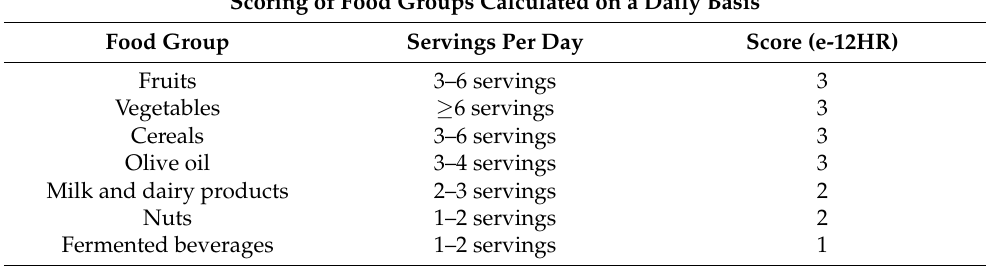
Table 1. Mediterranean diet Serving Score for